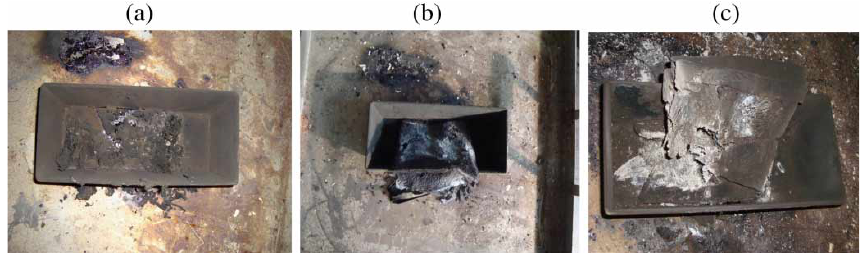
Fig. 7. Residues of the studied materials after combustion: (a) unmodified PES (sample 1); (b) modified with MoO 3 (sample 2); (c) modified with Sb 2 O 3 (sample 3)